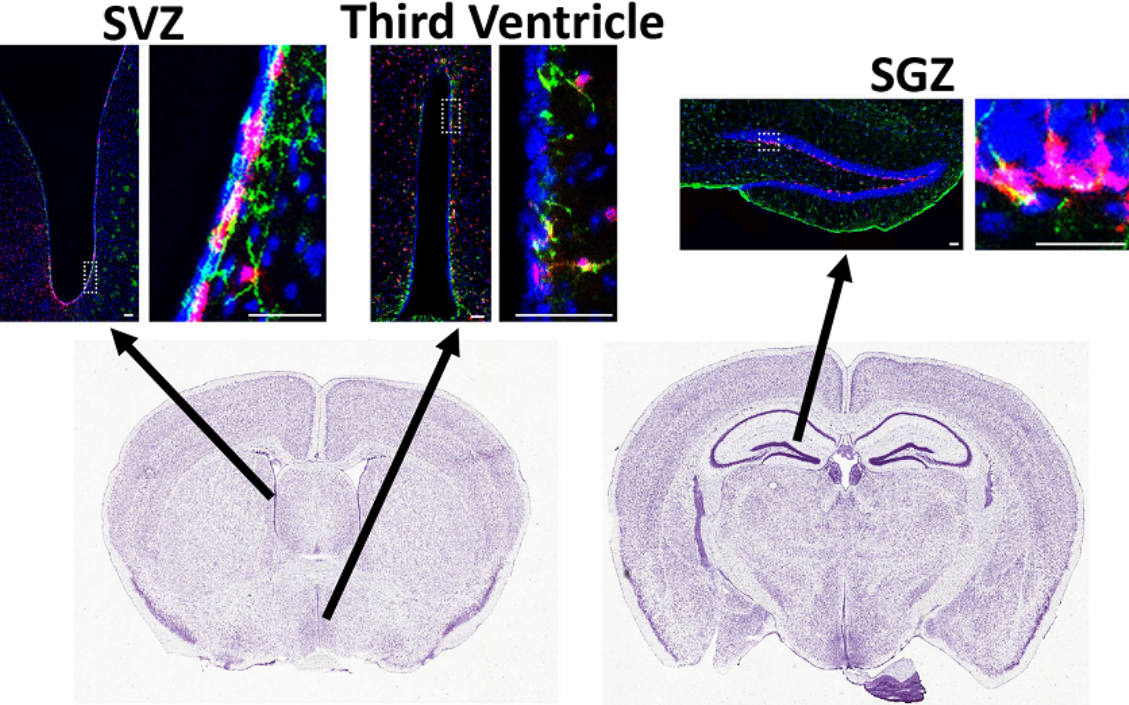
Figure 2. Neural stem cells in the adult subventricular zone (SVZ), hippocampal subgranular zone (SGZ), and the lining of the third ventricle. Gli1 NSCs were fate ‐ mapped by tamoxifen injection in the adult (P60 ‐ 80) Gli1CreER;Ai9 mice and analyzed by immunofluorescence for GFAP (green) to detect NSCs, TdT (magenta) to detect Gli1 fate ‐ mapped cells, and Hoechst (blue) to detect cell nuclei, 2 weeks after tamoxifen administration. The right panels are higher magnification views of the dotted boxes in the left panels. The arrows indicate the area in the coronal brain sections from Allen brain atlas. Scale bar = 50 μ m.